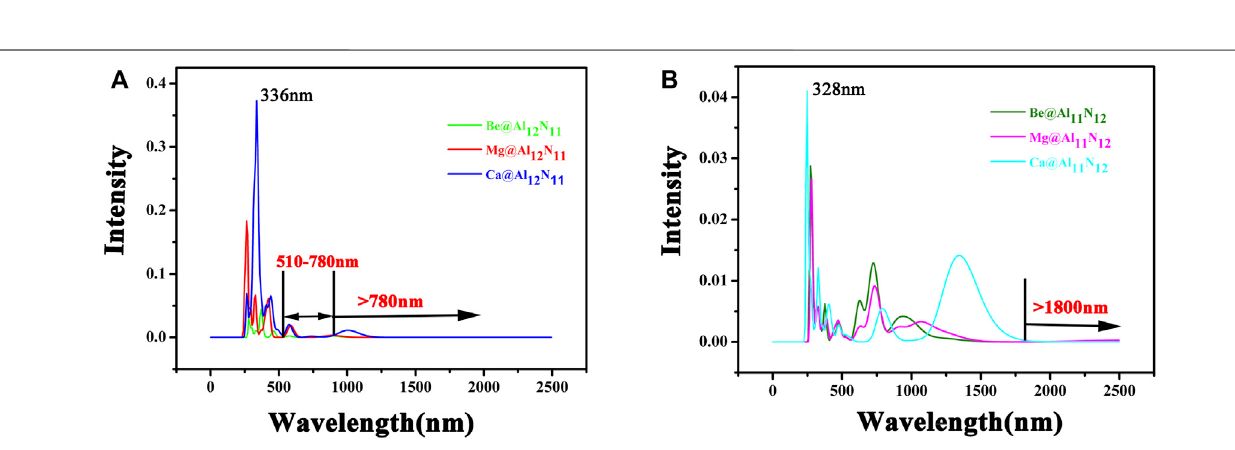
Frontiers in Chemistry |